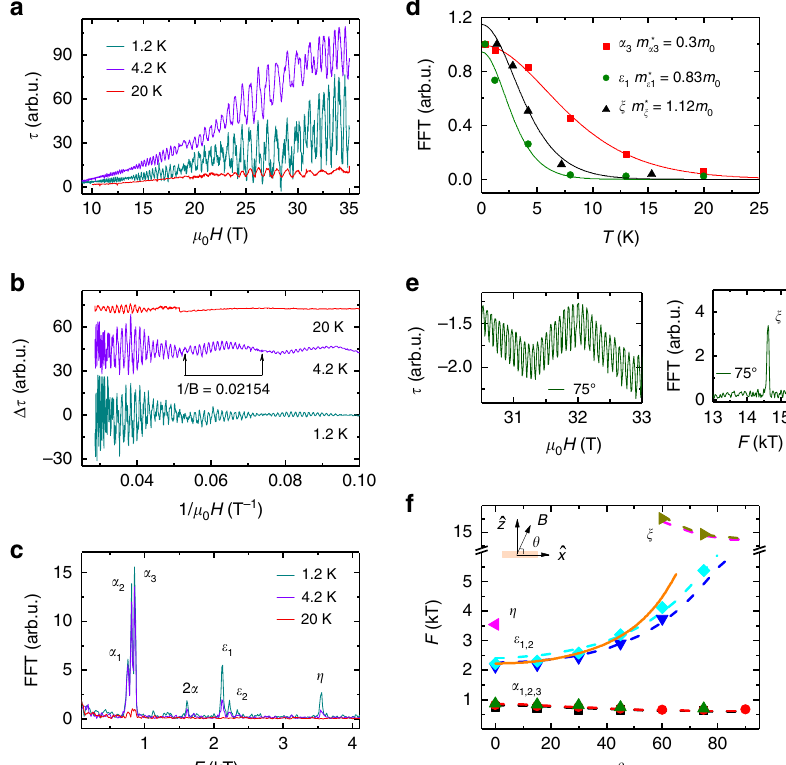
Fig. 4 Quantum oscillations, fast Fourier transform (FFT), effective mass, and angular dependent oscillation frequencies of MoP for the crystal V1. a de-Haas van-Alphen (dHvA) oscillations from magnetic torque measurements, when B jj ^ x , at various temperatures. b Oscillatory components after subtracting a third order polynomial from the data. Beating patterns (marked by arrows) are clearly visible that have a frequency of 45 T, i.e., the difference in frequencies between α 2 and α 3 . c FFTs from 10 – 35 T showing different frequencies corresponding to the different pockets involved in the quantum oscillations. d Temperature dependence of dHvA amplitudes from FFTs and LK fi ts giving the effective masses corresponding to different frequencies, α ε η . e Magnetic torque signal ( θ = 75 o ) showing very dense dHvA oscillations: these are visible only when B is nearly along ^ z (left panel). The 3 , 1 , and corresponding FFT exhibits a single frequency of 14.6 kT (right panel). f Angular dependent frequencies when B is rotated from ^ x ( θ = 0 o ) to ^ z ( θ = 90 o ) where the symbols and dotted lines are experimental and calculated values, respectively. The solid line (orange color) depicts a 1/cos θ behavior. The inset shows the rotation geometry of B with respect to the ^ x and ^ z